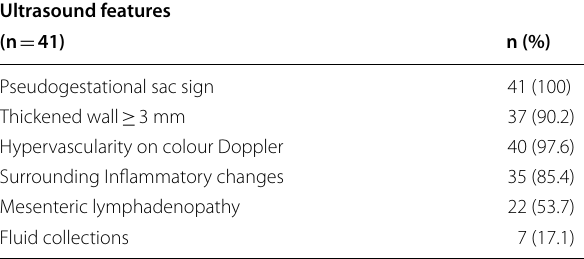
Table 2 Ultrasound features of true‑positive cases Ultrasound